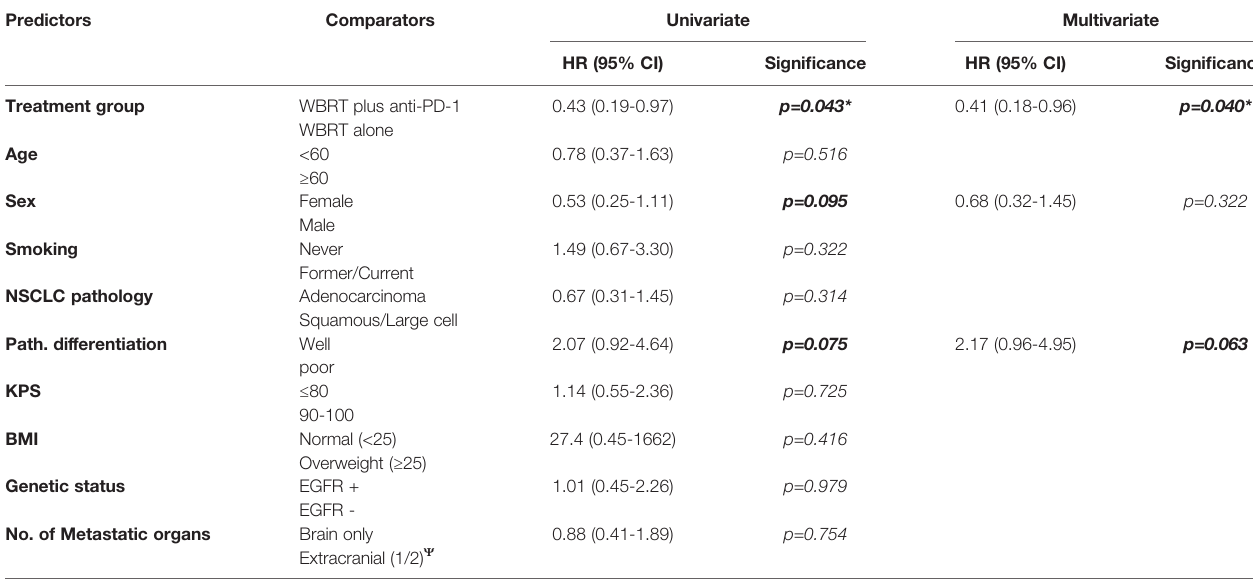
TABLE 2 | Univariate and multivariate analysis for overall